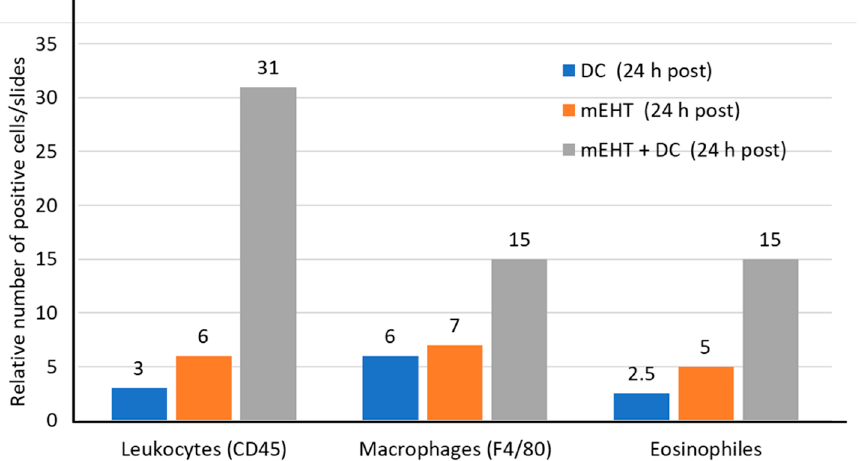
Figure 15. Increased concentration of leukocytes, macrophages, and eosinophils seen after the administration of mEHT combined with DC therapy.